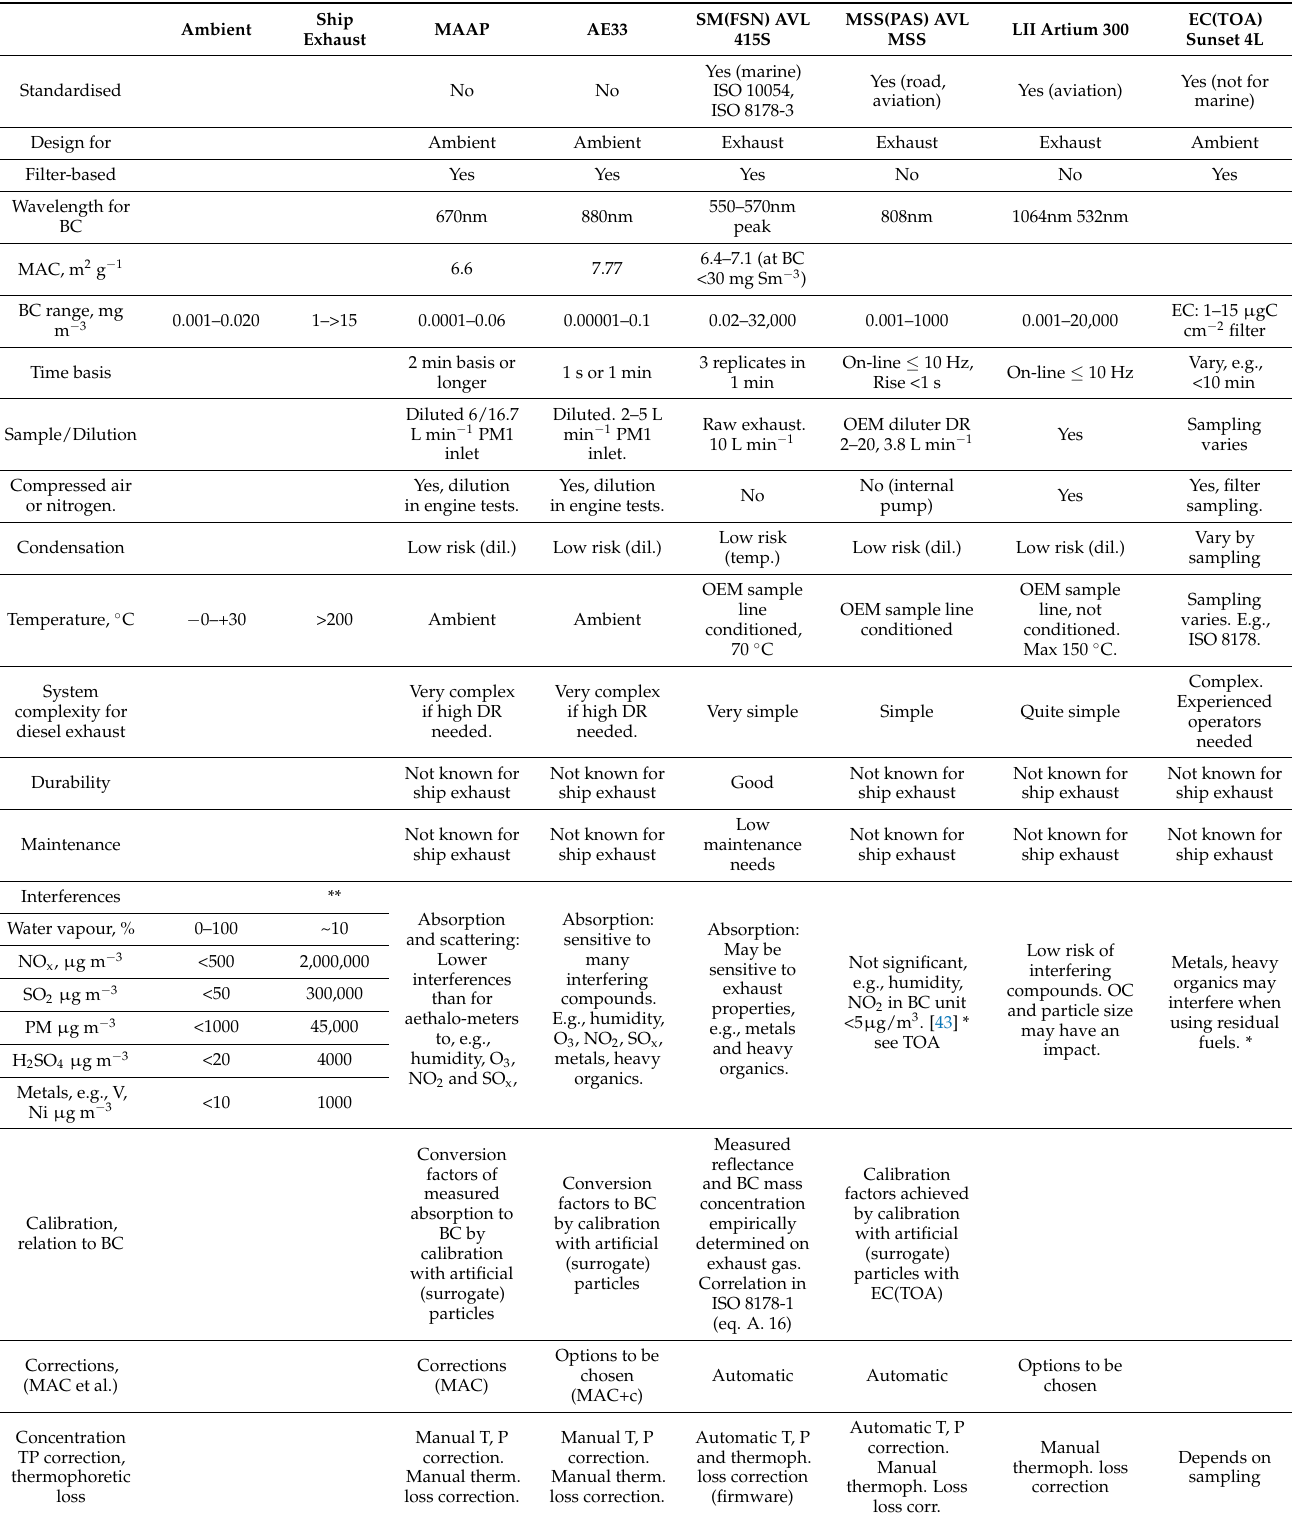
Table A3. BC measurement methods’ suitability for different